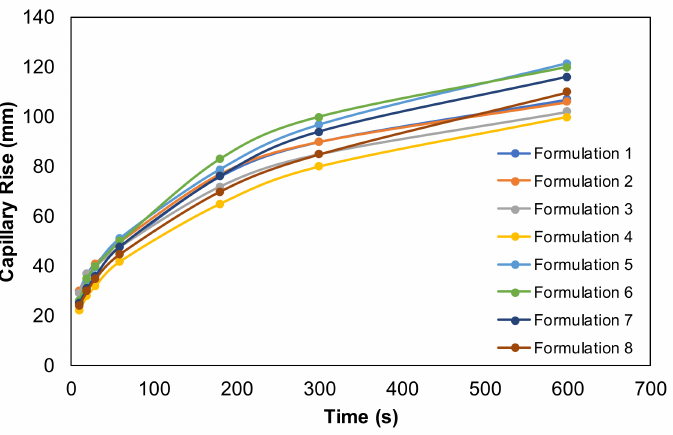
Figure 11. Klemm capillary rise method as a function of time for all tissue